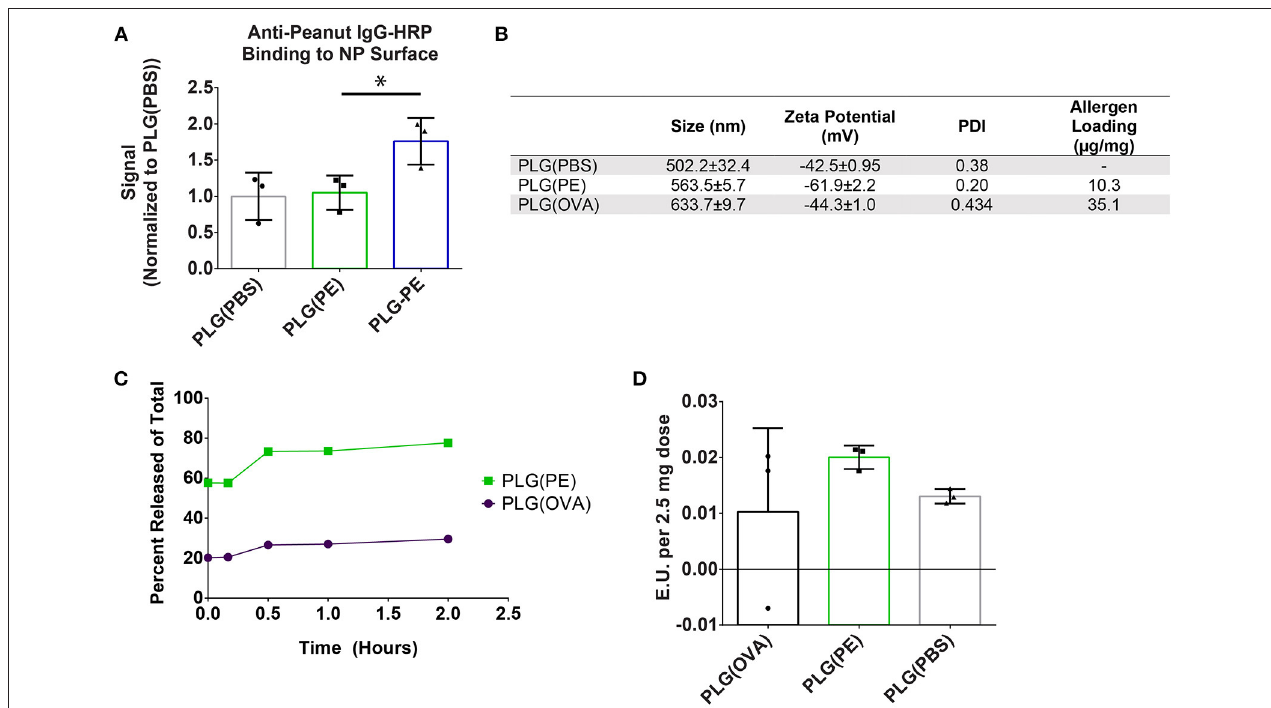
FIGURE 2 | Characterization of PLG NPs used for in vivo studies. (A) PLG(PE) NPs were confirmed to have low surface expression of peanut extract by measuring amount of Anti-peanut IgG-HRP binding. Total chemiluminescent flux (p/s) was measured using an in vivo Imaging System (IVIS) and an exposure time of 1s, and the signal was normalized to the signal recorded from PLG NPs. (B) NP Size, zeta potential, polydispersity index (PDI), and antigen loading (BCA assay, µ g antigen per mg NP) of formulations used in subsequent in vivo experimentation. (C) Antigen release of antigen-containing formulations was measured over 2h in PBS. (D) LAL Endotoxin testing was measured to verify acceptable levels for all formulations utilized. Plots display mean measurement ± SEM. Statistical Significance: 1-way ANOVA with Dunnett’s (A) multiple comparisons test * p <